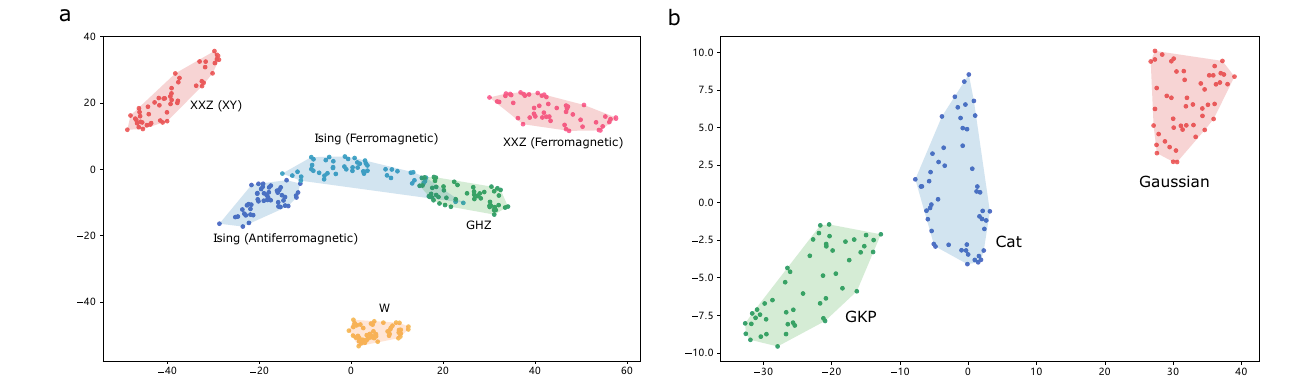
state representation vectors of squeezed thermal states, cat states and GKP states. In both sub fi gures, shaded areas are added to help visualize the various type of states. Note that the representation vectors generated by GQNQ of states of the same type are near to each other in the two-dimensional